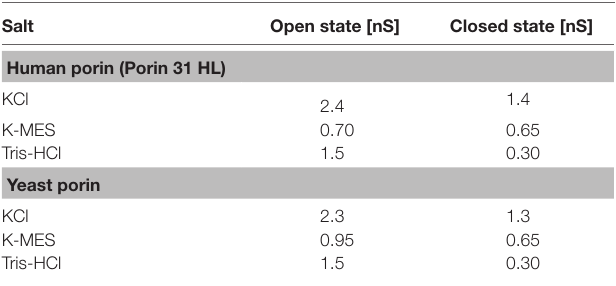
TABLE 3 | Average single-channel conductance of the open and closed states of human (Porin 31HL; Benz et al., 1992) and yeast (Ludwig et al., 1988) porins in different 0.5 M salt solutions.